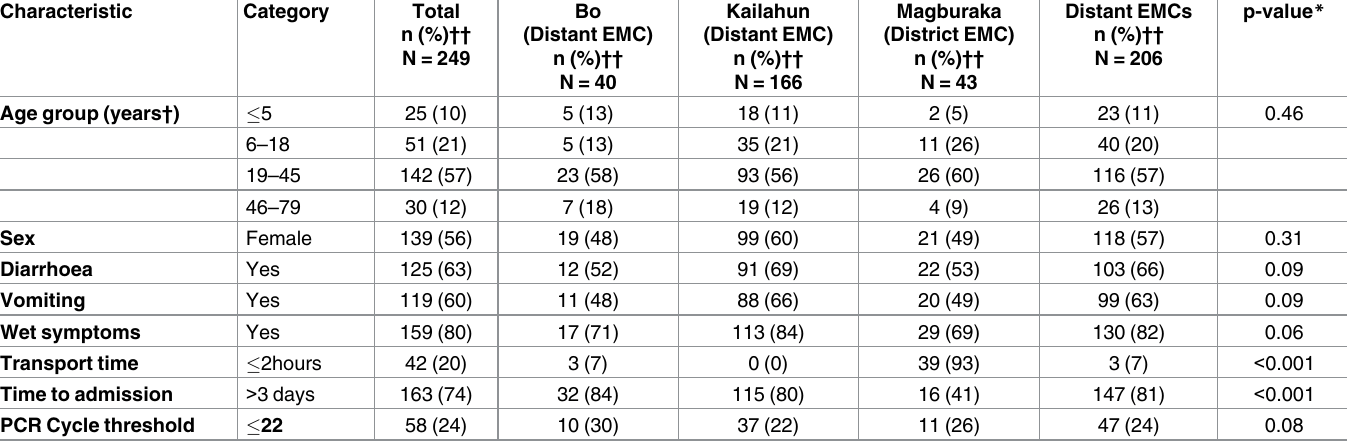
Table 1. Characteristics of Ebola Virus Disease(EVD) confirmed patients from Tonkolili, admitted in MSF Ebola Management Centres (EMCs), Sierra Leone. Characteristic